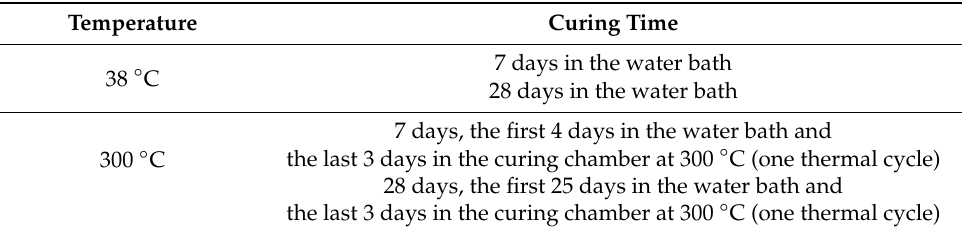
Table 5. Curing time procedure.